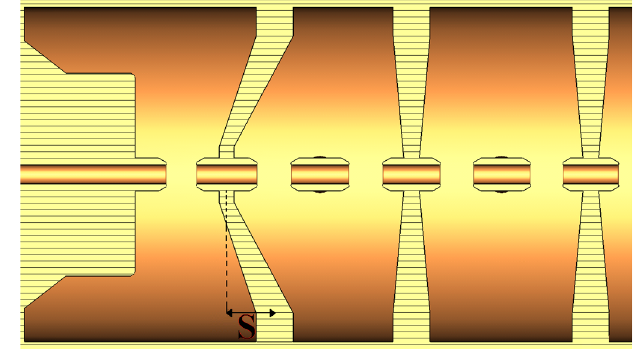
FIG. 38. A detail of the first cells of the second resonator of the FAIR proton injector showing the inclined first